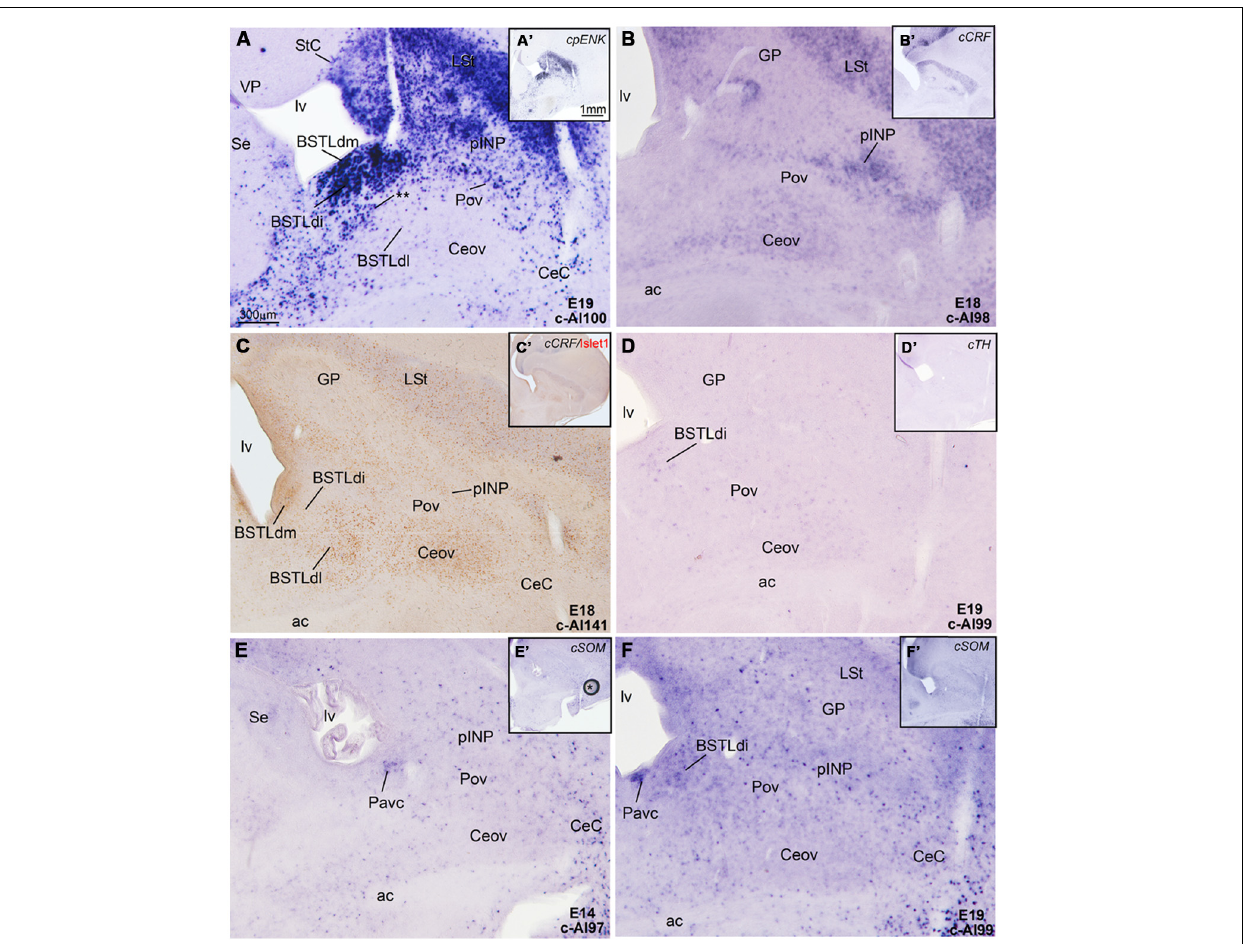
FIGURE 8 | Expression of cpENK , cCRFR2 , cSOM, and cTH in the central extended amygdala of chicken embryos at intermediate or late stages. (A–F) Digital images of frontal sections of the telencephalon of chicken embryos (from E14 to E19), hybridized for the phenotype markers cpENK ,